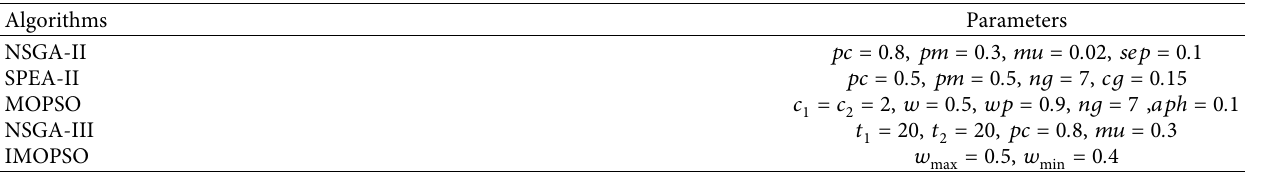
Table 4: Parameters setting.